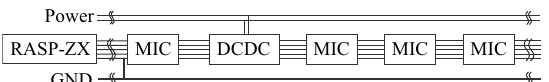
MIC Fig. 4 Wiring diagram of the distributed sensors. The sensors are interconnected by the cables originating from RASP-ZX. A DC–DC converter is installed at each of the four sensors to prevent voltage drop. In addition, a thick GND cable is passed separately to reduce the electrical